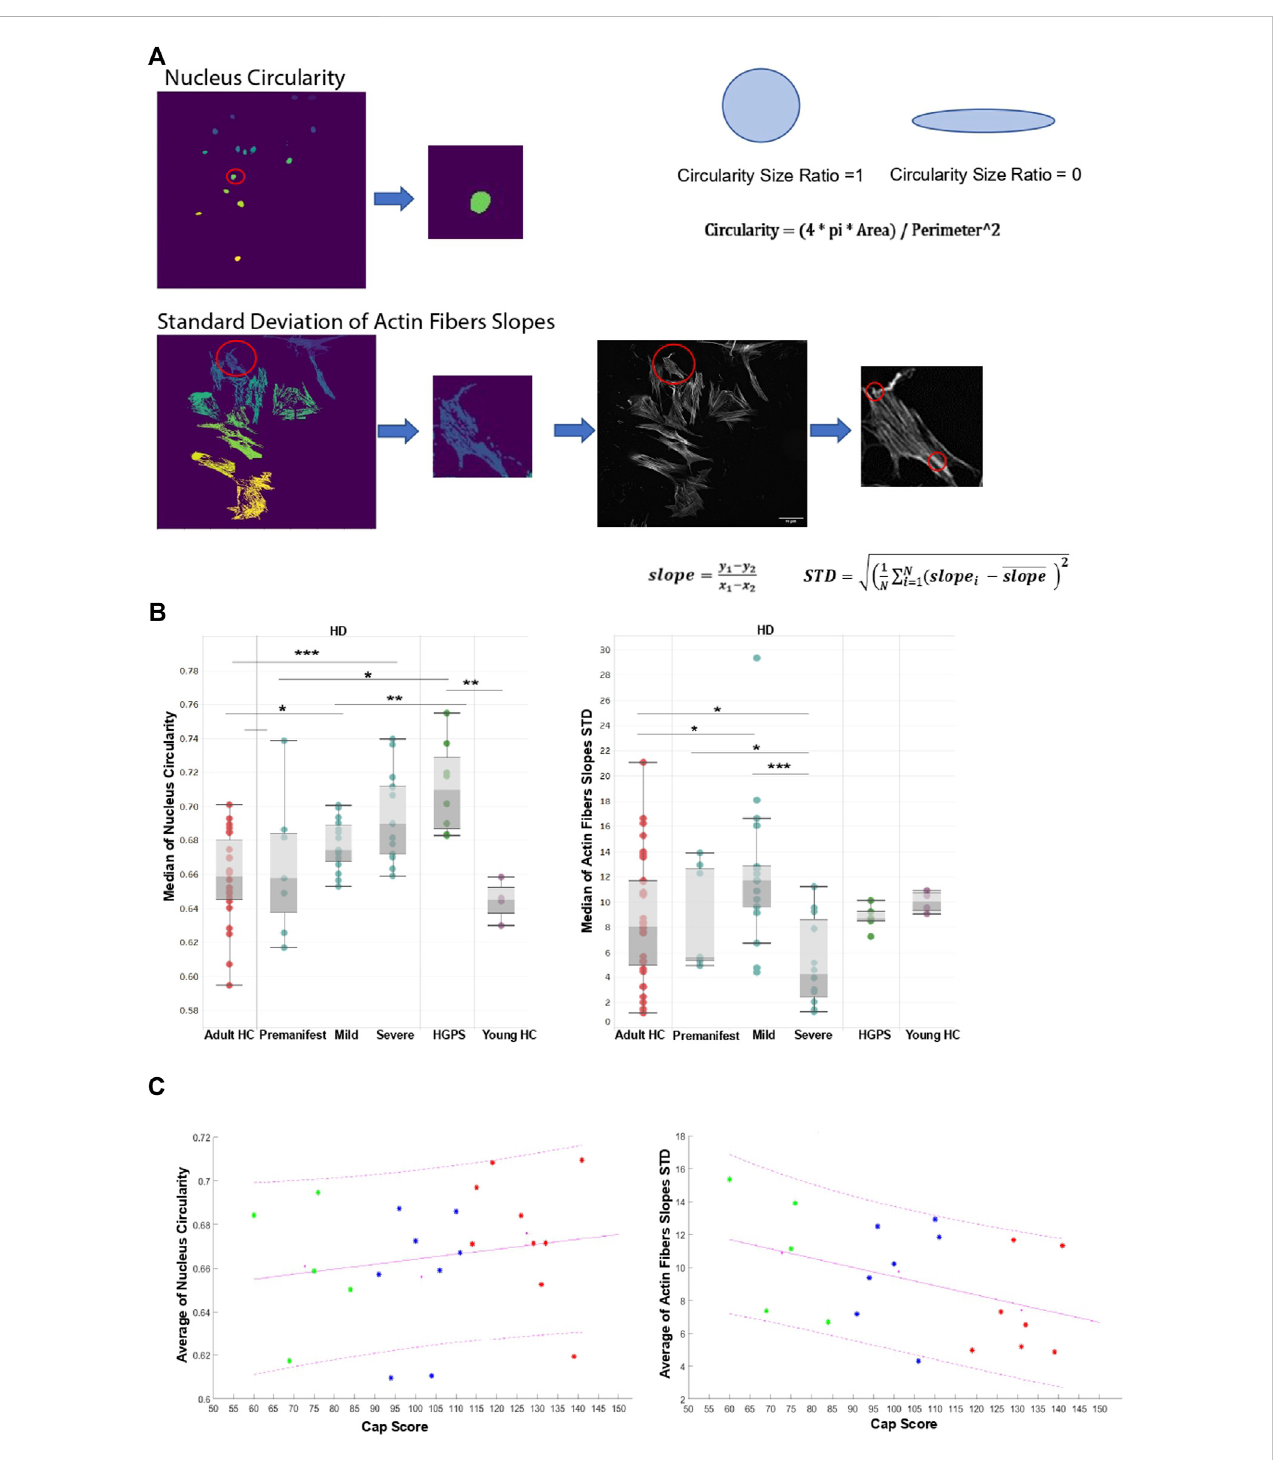
FIGURE 4 An automatic image based high content analysis algorithm for actin cap like features (A) Schematic Representation of the segmentation steps for each feature. For the “ Nucleus Circularity ” feature the algorithm counts the total number of pixels constructing each nucleus segment over the nucleus image. A binary mask of each nuclear segment is generated and then used to measure the circularity. For the “ Standard Deviation of Actin Fibers Slopes ” feature, the algorithm segments the cell body (cytoplasm), and a binary mask is applied over the actin fi bers image to receive an output image of actin fi bers that overlap the speci fi c cell ’ s cytoplasm. Then, an algorithm for line detection was applied on the output image in order to detect edge points couples of each actin fi ber over the cytoplasm. For each actin fi ber ( “ line ” ) over the cytoplasm, a linear slope was calculated, and a standard deviation value of all slopes was determinedtoassessthelevelofactin fi bersparallelizationoverthecytoplasm (B) Mann-Whitney ’ sUtestwasperformedonthemediansofdifferentactincap like features generated from the image analysis tool mentioned above in HC fi broblast cells compared to the HD and HGPS per patient(20 HC, 6 Premanifest HD,10MildHD,12SevereHD,6HGPS,4youngHC),~500cellsfromeachskin fi broblastsampleusingGraphPad8,theresultsarepresentedinboxplotsusing Tableau 2020.3 (C) Trend analysis was performed on the average of different actin cap like features in relation to Cap Score of different HD samples divided into three groups (Premanifest in green, Mild in blue, and Severe in red). Magenta lines are represented as least squares lines (solid line - for the average of the data, dashed lines - for the maximum and the minimum of the data) Magenta points are an average point of each group presented in a plot using MATLAB